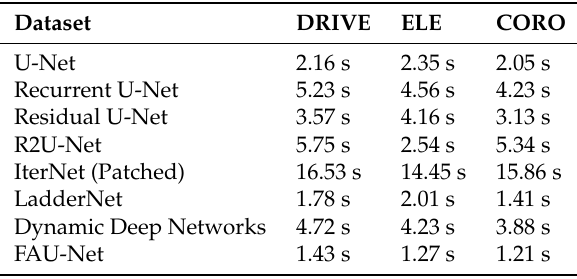
Table 5. computational time for testing(Time (s)/sample).